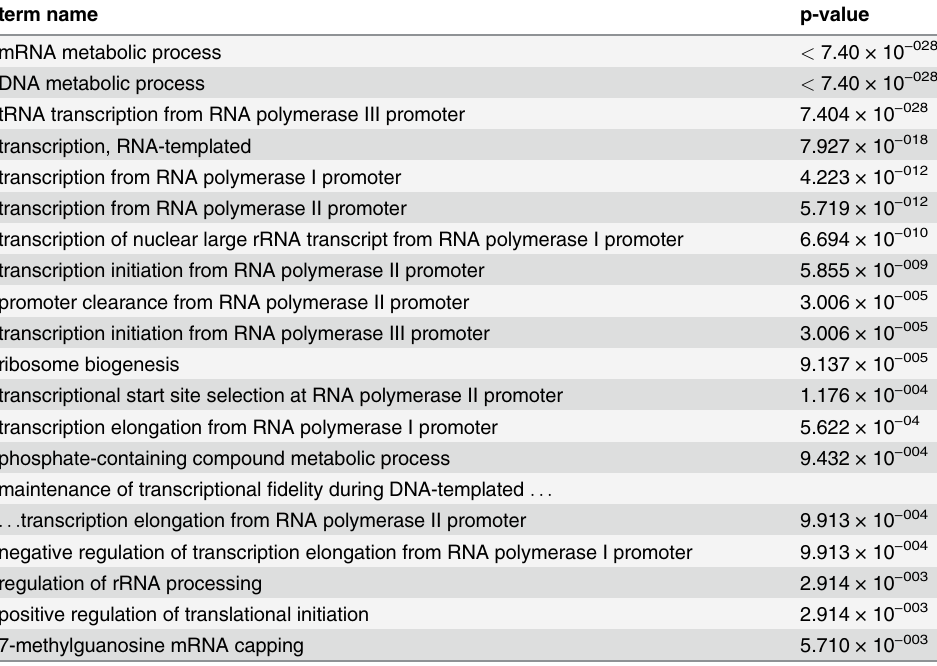
Table 3. Term enrichment p-values for Complex 3 Set signi fi cant terms (alpha = 0.01) for the YHTP2008